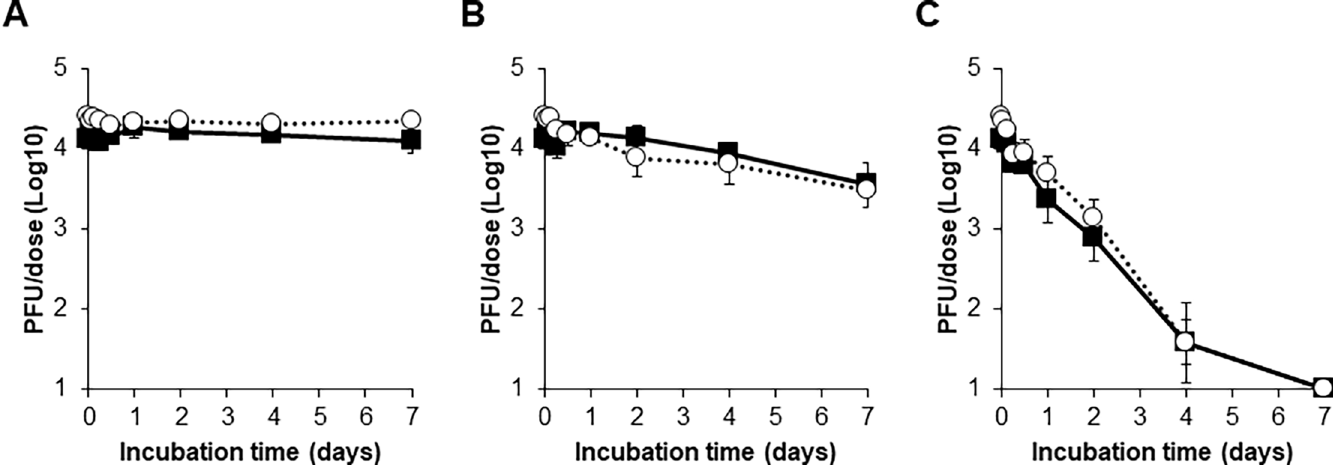
Fig 5. Stability testing of reconstituted measles and rubella combination vaccines. After incubation of reconstituted vaccines at 4˚C (A), 25˚C (B), or 35˚C (C), titres of measles and rubella viruses in the vaccines were measured by plaque assays. Filled squares and open circles indicate titres of measles and rubella viruses, respectively. Means of three vials are shown. Error bars indicate standard